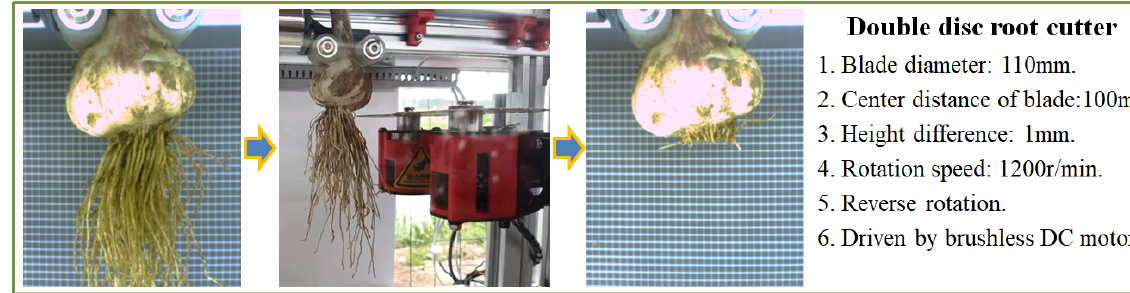
Figure 2. Overview of the root cutter.